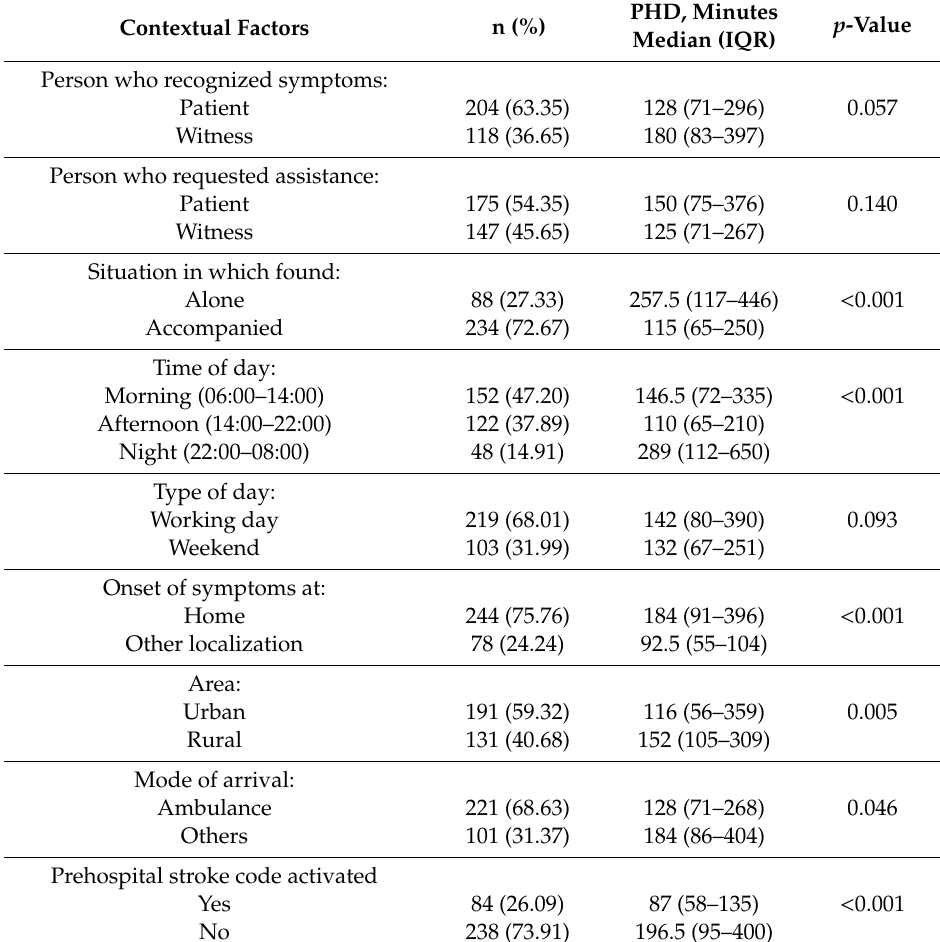
Table 5. Time from symptom onset to hospital arrival by contextual factors.